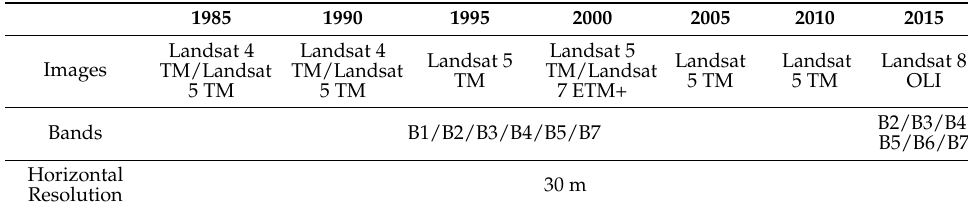
Table 1. Bands and Landsat images used for the years